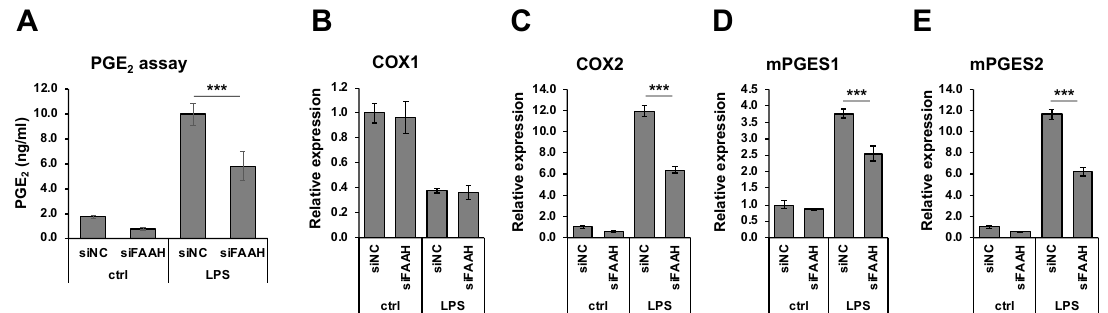
Figure 7. PGE 2 production and biosynthetic enzyme expression in FAAH knockdown cells. BV2 cells after 24 h siRNA transfection were incubated with LPS for 18 h. The medium was employed for PGE 2 EIA ( A ). For mRNA expression analysis, BV2 cells after 24 h siRNA transfection were treated with LPS for 8 h. qRT-PCR was performed to determine expression of the PGE 2 biosynthetic enzymes COX-1 ( B ), COX-2 ( C ), mPGES1 ( D ) and mPGES2 ( E ). Graphs are represented as means ± S.D. (n = 4) determined by two-way ANOVA. *** denotes p <